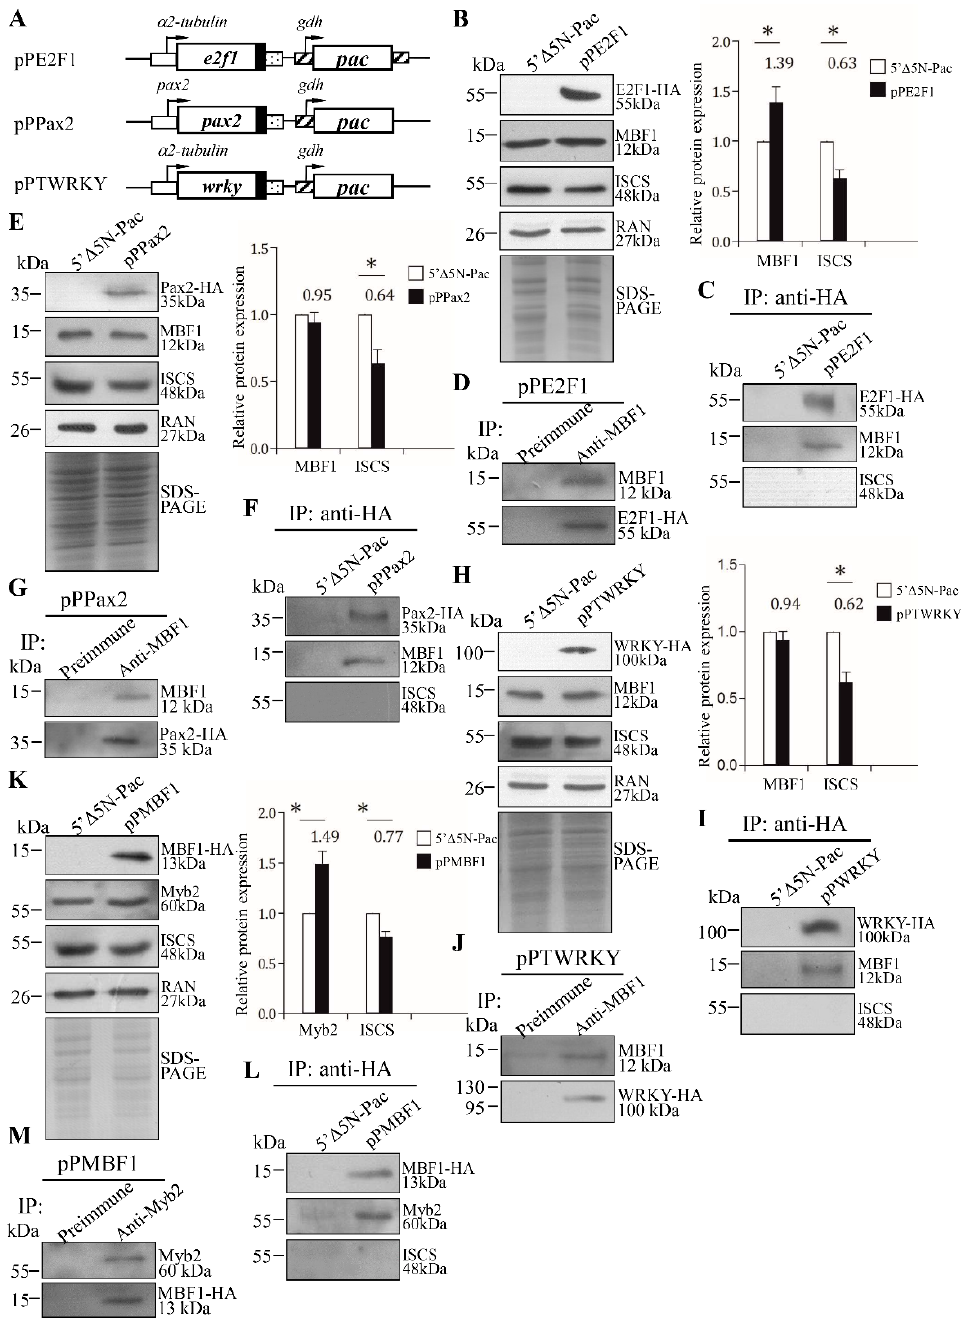
Figure 7. Interaction between MBF1 and E2F1, Pax2, WRKY, or Myb2. ( A ) Diagrams of the pPE2F1, pPPax2, or pPTWRKY plasmid. The expression cassette of the pac gene and the HA epitope tag coding sequence are the same as in Figure 2C. The e2f1, pax2, or wrky gene is under the control of α -tubulin promoter or its own 5 ′ -flanking region (open box) and the 3 ′ -flanking region of the ran gene (dotted box). Expression of the HA-tagged ( B ) E2F1, ( E ) Pax2, or ( H ) WRKY protein in whole cell extracts for co-immunoprecipitation assays (Input). The 5 ′∆ 5N-Pac and ( B ) pPE2F1, ( E ) pPPax2, or ( H ) pPTWRKY stable transfectants were cultured in encystation medium for 24 h. SDS-PAGE and Western blot were performed as described in Figure 3A. The blot was probed with anti-HA, anti-MBF1, anti-ISCS, and anti-RAN antibodies, respectively. The band in- tensity from triplicate Western blots was quantified using Image J as described in Figure 3A. *, p < 0.05. Interaction between MBF1 and ( C ) E2F1, ( F ) Pax2, or (I) WRKY was detected by co-immuno- precipitation assays. The 5 ′∆ 5N-Pac and ( C ) pPE2F1, ( F ) pPPax2, or ( I ) pPTWRKY stable transfect- ants were cultured in encystation medium for 24 h. Proteins from cell lysates were immunoprecip- itated using anti-HA antibody and analyzed by Western blotting with anti-HA, anti-MBF1, and